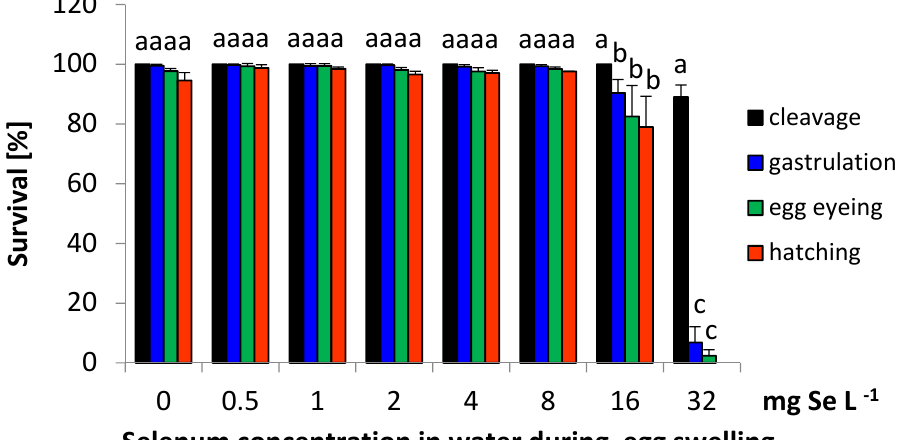
Figure 1. The survival rate of sea trout ( Salmo trutta m . trutta ) embryos grows from eggs exposed to different concentrations of inorganic selenium (SeO 2 ) in water during egg swelling 0, 0.5, 1, 2, 4, 8, 16, and 32 mg Se L − 1 . Values marked with the same letter are not significantly different from one another ( p > 0.05). Two-way ANOVAs and then Fisher tests were used for the post-hoc comparison.